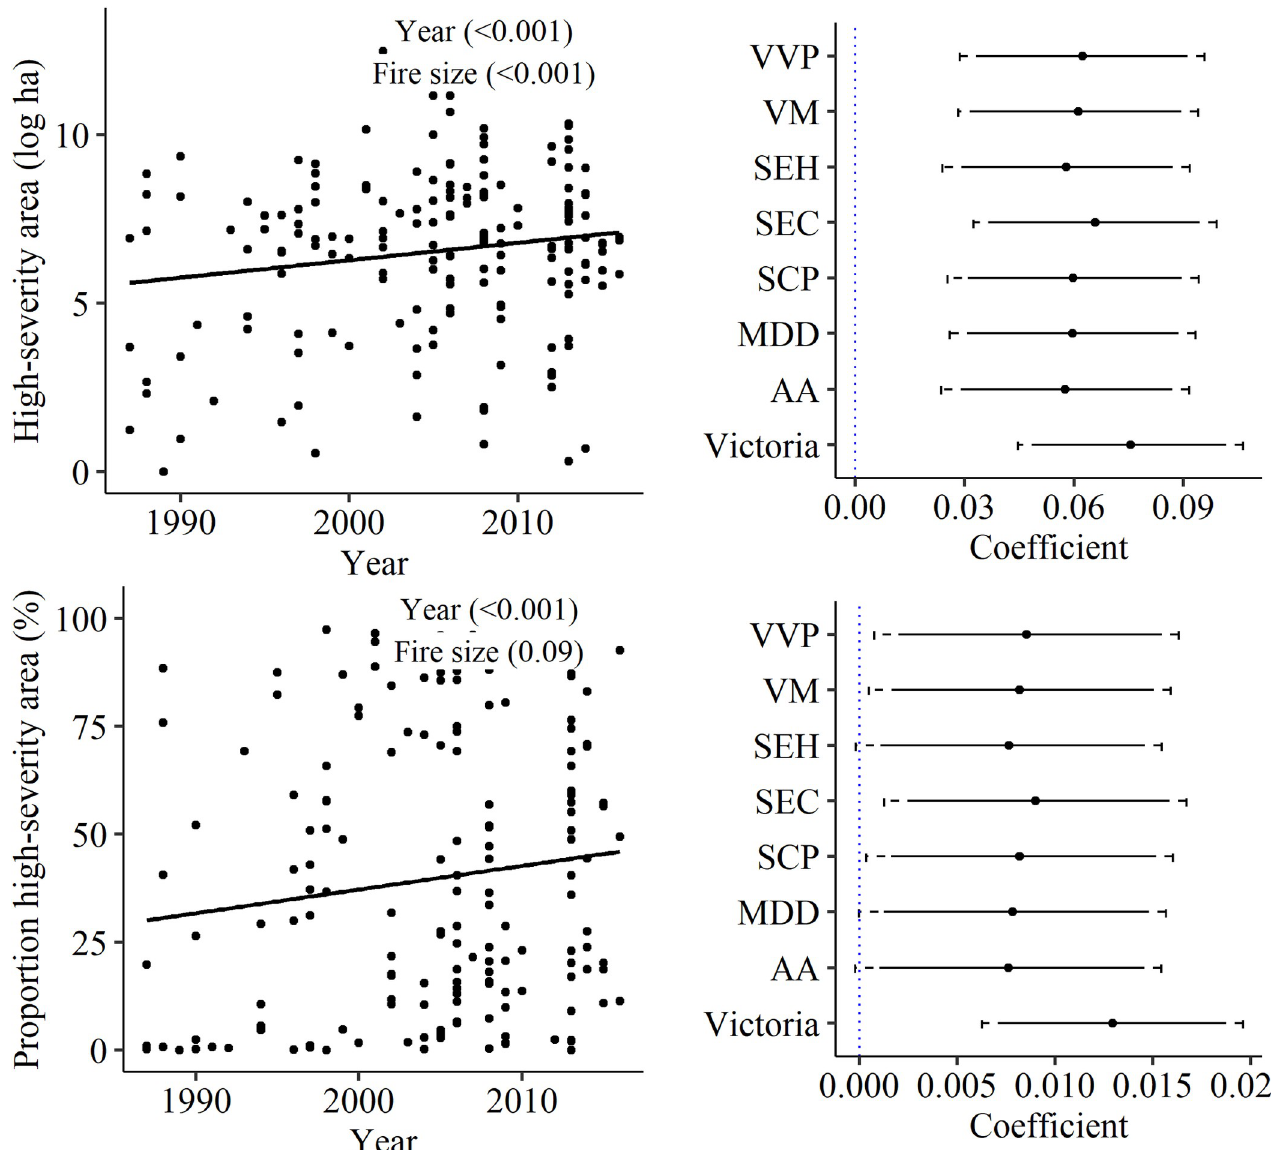
Fig 3. Changes in the area and proportional area of high-severity fire from 1987 to 2017. Left panels: Area and proportional area burnt by high-severity fire in each of 162 wildfires (line represents significant relationship between variables). Right panels: Standardized coefficients for high-severity area (top, log transformed) and the proportion high-severity area (bottom, arcsine transformed) indicating the relationship between area burnt and time. Each panel displays results for a single model for all regions (“Victoria”) and for individual bioregions (Acronyms of bioregions are defined in Table 1); Dot points represent mean estimated coefficient along with the 90 th (solid line) and 95 th (dashed line) percentile intervals. Coefficients denote significant changes when interval does not include